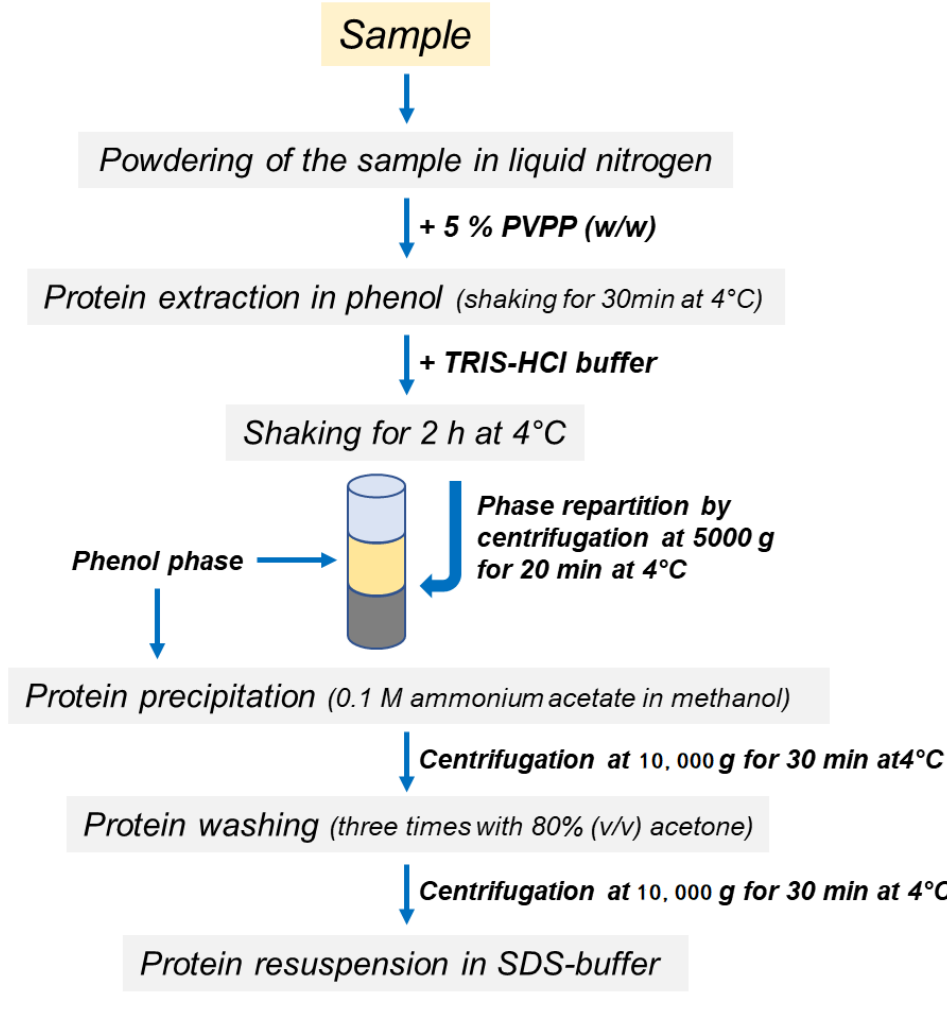
Figure 1. Schematic workflow of protein extraction methods. The protein content was determined by the 2-DE Quant kit (GE Healthcare) using bovine serum albumin as the